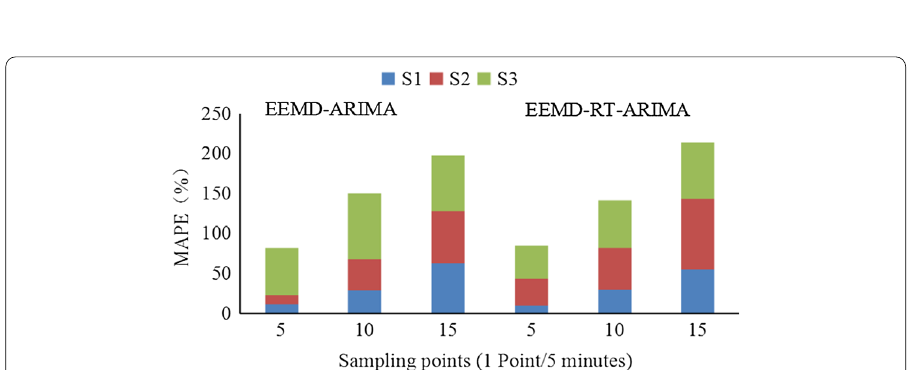
Fig. 7 The MAPEs of adaptive prediction for different types of VM request sequences. The first three columns represent the MAPEs of the 5-point, 10-point and 15-point prediction obtained by EEMD-ARIMA method. The last three columns represent those obtained by EEMD-RT-ARIMA method. The blue, red and green parts represent the MAPEs of the S1, S2 and S3 sequences in each column,